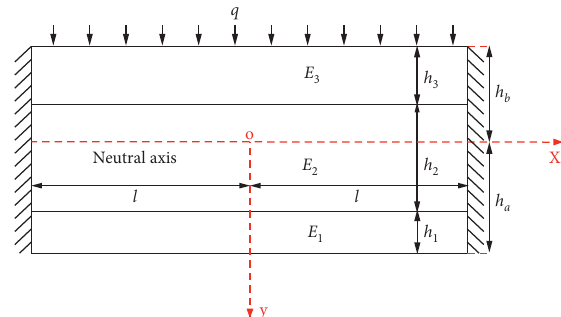
Figure 2: Analysis model of compound hard